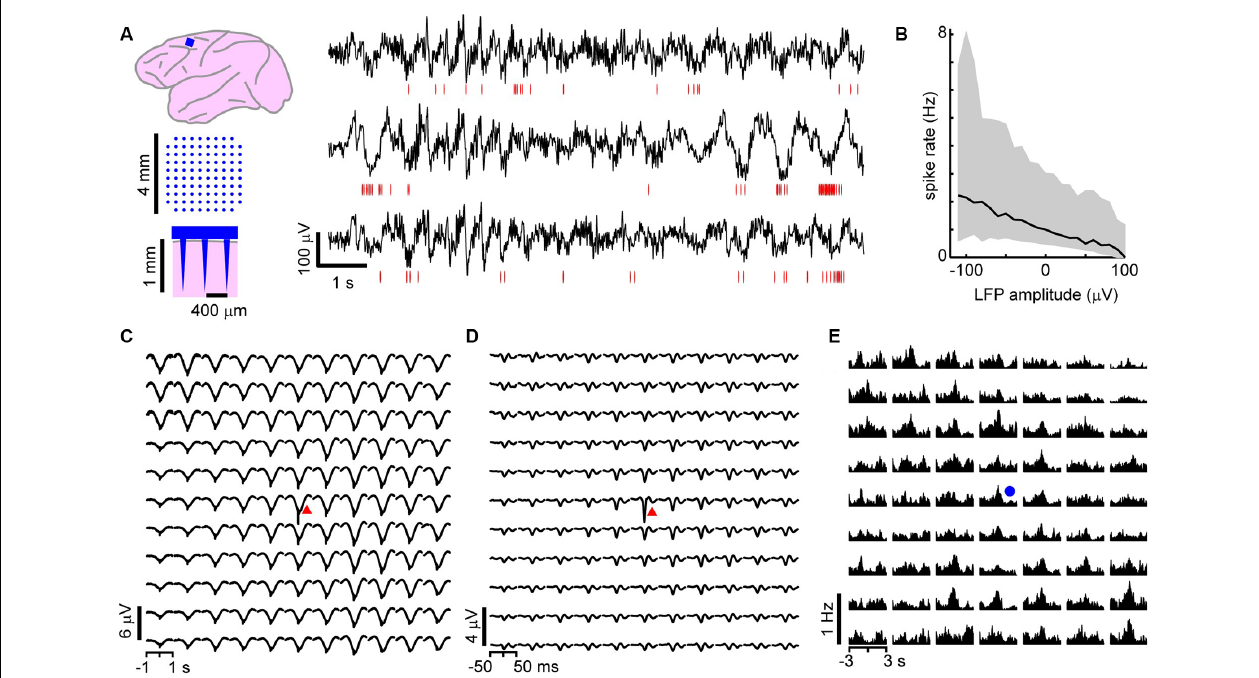
FIGURE 1 | On average, local unit activity associates with negative local field potential (LFP) deflections over the spatially extended cortical area in the monkey cortex. (A) Left: a 96 channel electrode array (blue) was implanted within superficial layers of the premotor cortex in two macaque monkeys. Right: simultaneous recordings of awake-state ongoing LFP (black) and single-unit activity (red—spike times) from three recording sites. Units exhibit increased firing around the time of negative LFP deflections. (B) Unit activity increases with negative LFP amplitude. Unit spike rate as a function of LFP amplitude computed for all times (in consecutive 50 ms windows). Units and LFP recorded at the same site were compared. Displayed is the average over all sites and units for both monkeys. Large deviations from the average relationship are typical (shaded region—lower to upper quartile, line—median). (C) Spike-triggered average LFP waveforms indicate that widespread, slow negative LFP fluctuations are associated with local spiking (red triangle indicates the site of the local unit). LFP was band-pass filtered between 1 and 100 Hz. (D) Same as in panel (C) , but with low-frequency components of the LFP removed (band-pass, 3–100 Hz), spike-triggered average LFP waveforms indicate that local, sharp negative LFP deflections are typically associated with spiking as reported previously (Petermann et al., 2009). (E) The peak times of large amplitude negative LFP deflections (nLFPs; bandpass filter, 1–100 Hz) were used to compute nLFP-triggered average spike count histograms. Consistent with (C) , units both near to and distant from the trigger site (blue dot) exhibited significant increases in firing with no clear decaying relationship over distance. For (C–E) all units were compared to all LFP recordings and then averaged together keeping track of relative locations of the unit concerning the LFP recording site.